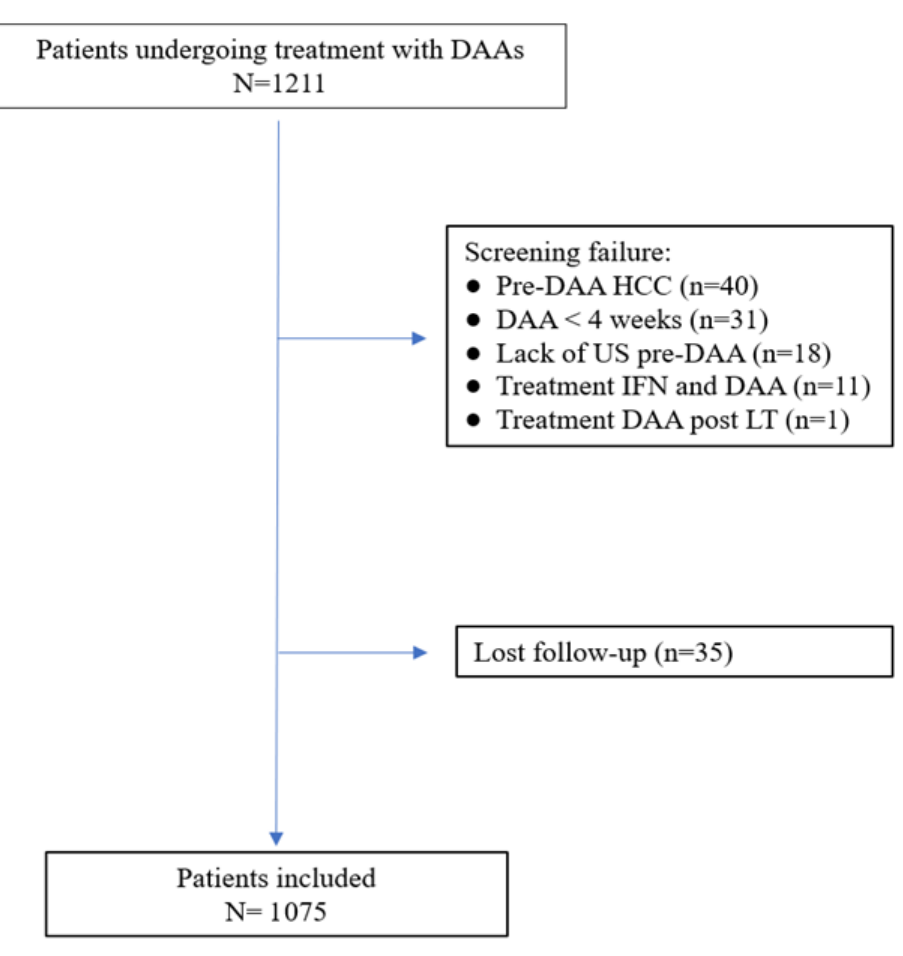
Figure 1. Flow chart of inclusion of patients in the study. HCV: hepatitis C virus; HCC: hepatocellular carcinoma; DAA: direct antiviral agent; US: ultrasound; IFN: interferon; LT: liver transplantation, SVR: sustained virologic